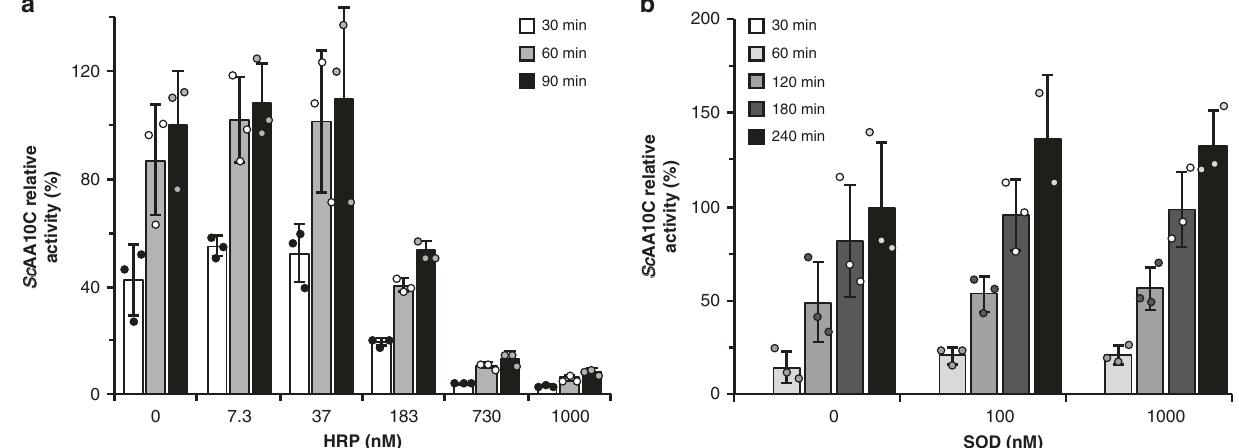
Fig. 8 Probing the underlying role of reactive oxygen species in the light/V-TiO 2 /LPMO system. The graphs show time-courses for the release of aldonic acid products from Avicel (10 g L − 1 ) by Sc AA10C (1 µ M) in the presence of varying amounts of a horseradish peroxidase (HRP) and b superoxide dismutase (SOD). All reactions were carried out in sodium phosphate buffer (50 mM, pH 7.0) at 40 °C, under magnetic stirring and were fueled by a suspension of V-TiO 2 (10 g L − 1 ) exposed to visible light ( I = 25% I max , approx. 42 W cm − 2 ). Activities are expressed relatively (in %) to the quantity of products measured at the last time point of the reference reaction (i.e., without HRP or SOD). Before product quanti fi cation, solubilized cello- oligosaccharides were hydrolyzed by Tf Cel5A, to convert the LPMO products to a mixture of only two oxidized products with a degree of polymerization of 2 and 3 [GlcGlc1A, (Glc) 2 Glc1A], the amounts of which were summed up to yield the concentration of oxidized sites. Error bars show ± s.d. ( n = 3, independent experiments). Control reactions in the dark without addition of HRP and SOD did not yield products. Note that the original work on the light/ V-TiO 2 system 17 includes control reactions similar to those shown in Supplementary Fig. 4, which con fi rm that product formation depends on the enzyme and is not due to enzyme-independent reactions. Source data are provided as a Source Data fi